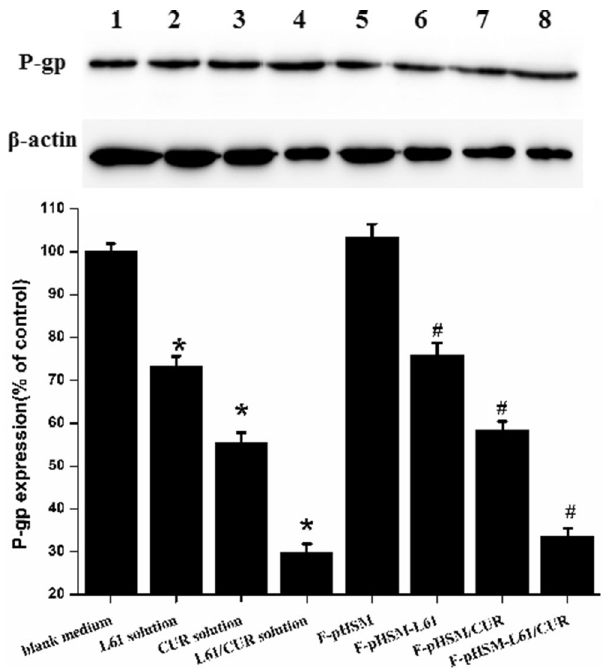
Figure 15. (1) Control; (2) Pluronic L61 unimers; (3) Curcumin; (4) mixed Pluronic L61/CUR solution; (5) F-pHSM; (6) F-pHSM-L61/CUR; (7) F-pHSM-L61; (8) F-pHSM/CUR. *P < 0.05: significantly different from cells treated with the blank medium, #P < 0.05: significantly different from the F-pHSM-treated cells. The blots were cropped and the full-length blots were included in the Supplementary Information.